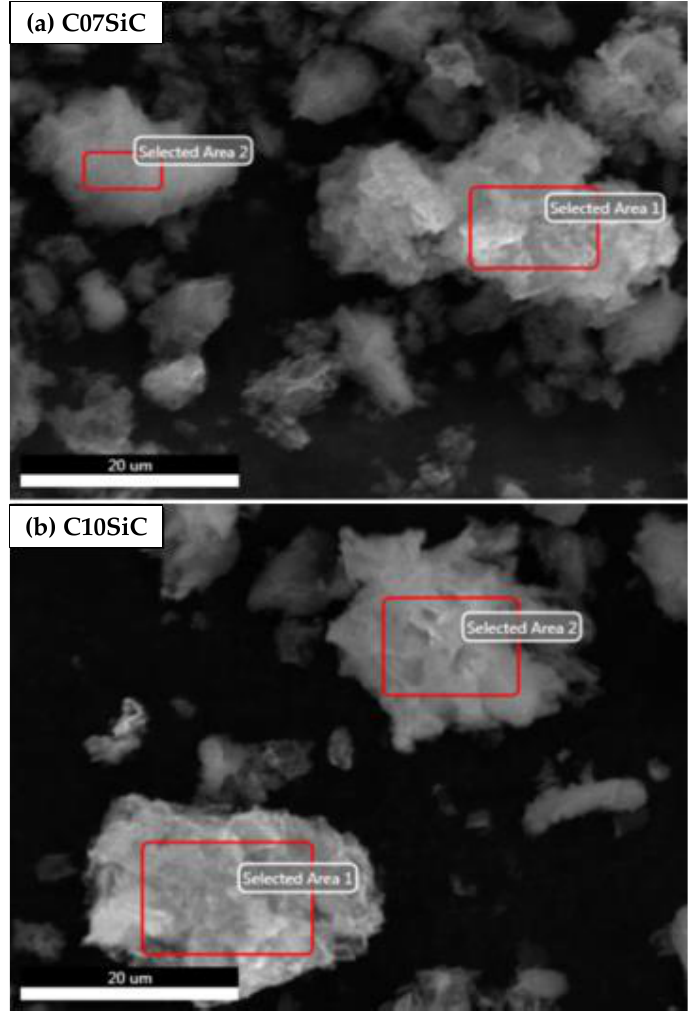
Figure 11. EDS photogram: ( a ) C07SiC, ( b ) C10SiC. Table 8. Elemental composition of C07SiC and C10SiC (wt.%).